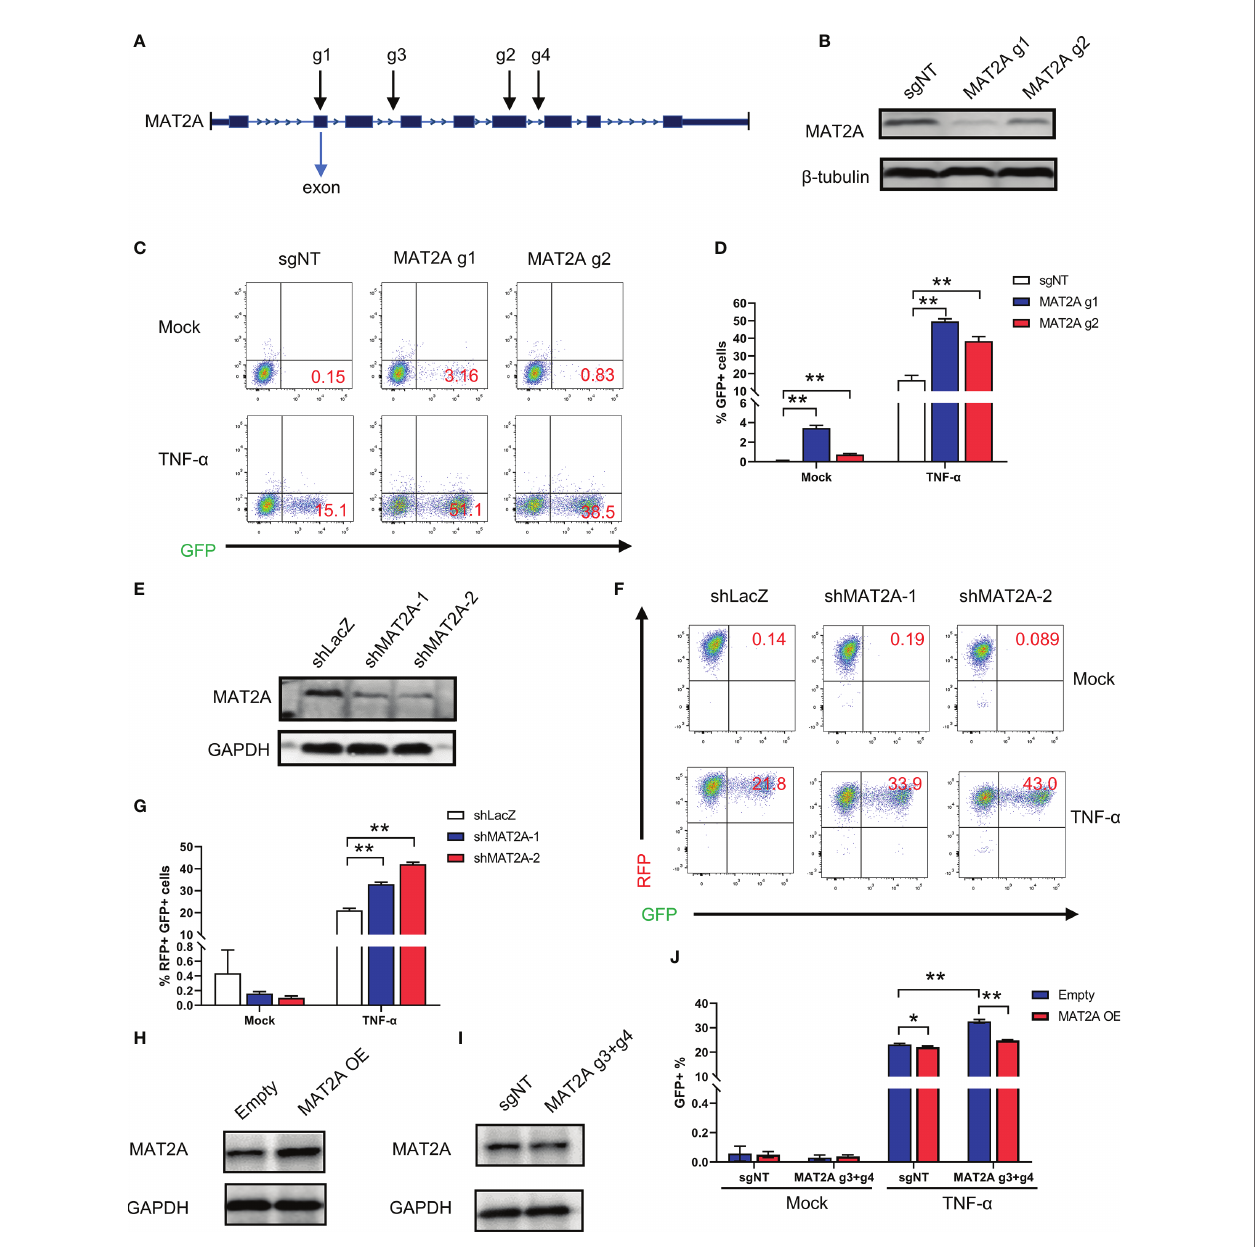
FIGURE 2 | MAT2A regulates HIV-1 reactivation in latently-infected cells. (A) Schematic diagram of sgRNAs targeting the MAT2A gene. (B) Western blot analysis of the knockout ef fi ciency of MAT2A in J-Lat 9.2 cells by MAT2A g1 and MAT2A g2 knockout, respectively. sgNT knockout cells served as control. (C, D) The MAT2A knockout J-Lat 9.2 cells were stimulated with or without TNF- a for 24 h GFP-positive cells were measured by fl ow cytometry. (E) Western blot analysis of the knockdown ef fi ciency of MAT2A in J-Lat 9.2 cells by shMAT2A-1 and shMAT2A-2 knockdown, respectively. shLacZ knockdown cells served as control. (F, G) The MAT2A knockdown J-Lat 9.2 cells were stimulated with or without TNF- a for 24 h GFP-positive cells were measured by fl ow cytometry. (H, I) Western blot analysis of the expression of MAT2A in J-Lat 9.2 cells with MAT2A overexpression (MAT2A OE) or MAT2A g3 + g4 knockout. (J) MAT2A knockout in J-Lat 9.2 cells by MAT2A g3 + g4 and then followed by the overexpression of MAT2A. GFP-positive cells were measured by fl ow cytometry. Data were presented as mean ± SD from three independent experiments (Student ’ s t-test, *p < 0.05, **p <